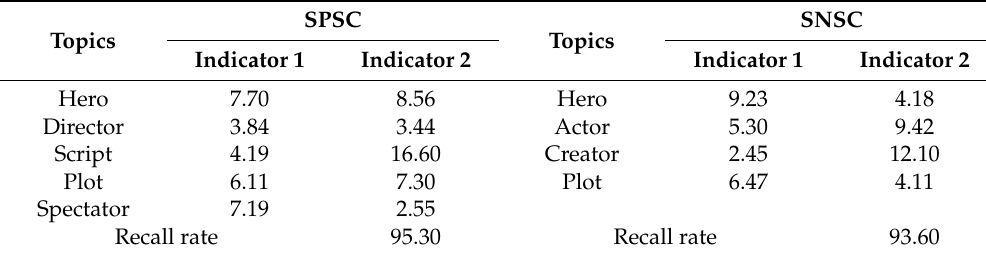
Table 13. Qualitative Indicators of the of LSR Analysis